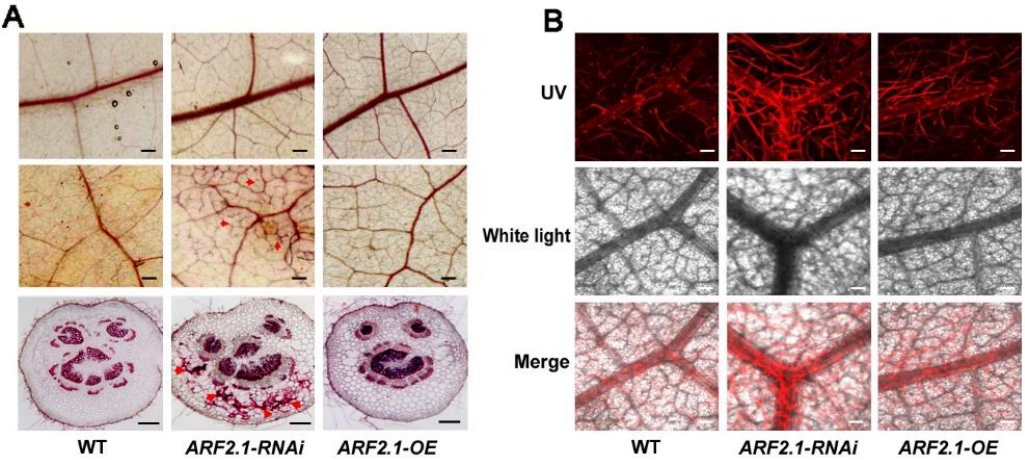
Figure 4. Effects of up- and downregulation of PtrARF2.1 on the biosynthesis of lignin in poplar leaves. ( A ) The phloroglucinol-HCl analysis of lignin deposition in the main veins (top) and the fine veins (middle) and the petioles (bottom) of the leaf tissue from the WT, PtrARF2.1-RNAi and PtrARF2.1 -OE (right). ( B ) Close-up view of the lignin signals in very fine veins in leaf blades of the WT (left) and PtrARF2.1-RNAi (right) poplars by laser scanning confocal microscopy. Scale bars: A (up) = 1.25 mm, A (middle) = 0 .5 mm, A (down) = 200 μm; B = 150 μm.